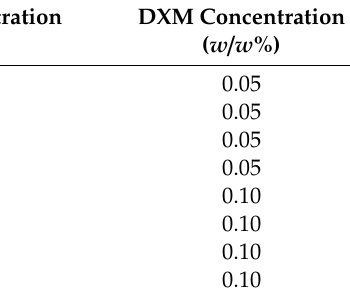
Table 1. The composition of the nanostructured lipid carriers